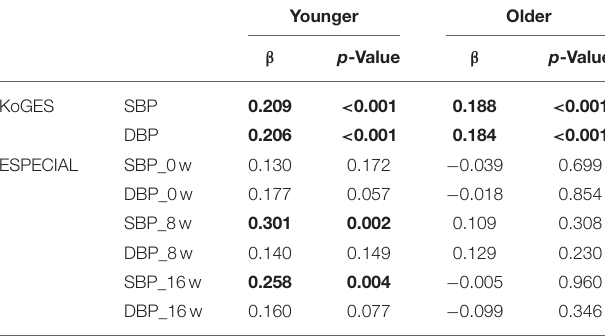
TABLE 2 | Multiple regression analysis of factors affecting blood pressure.